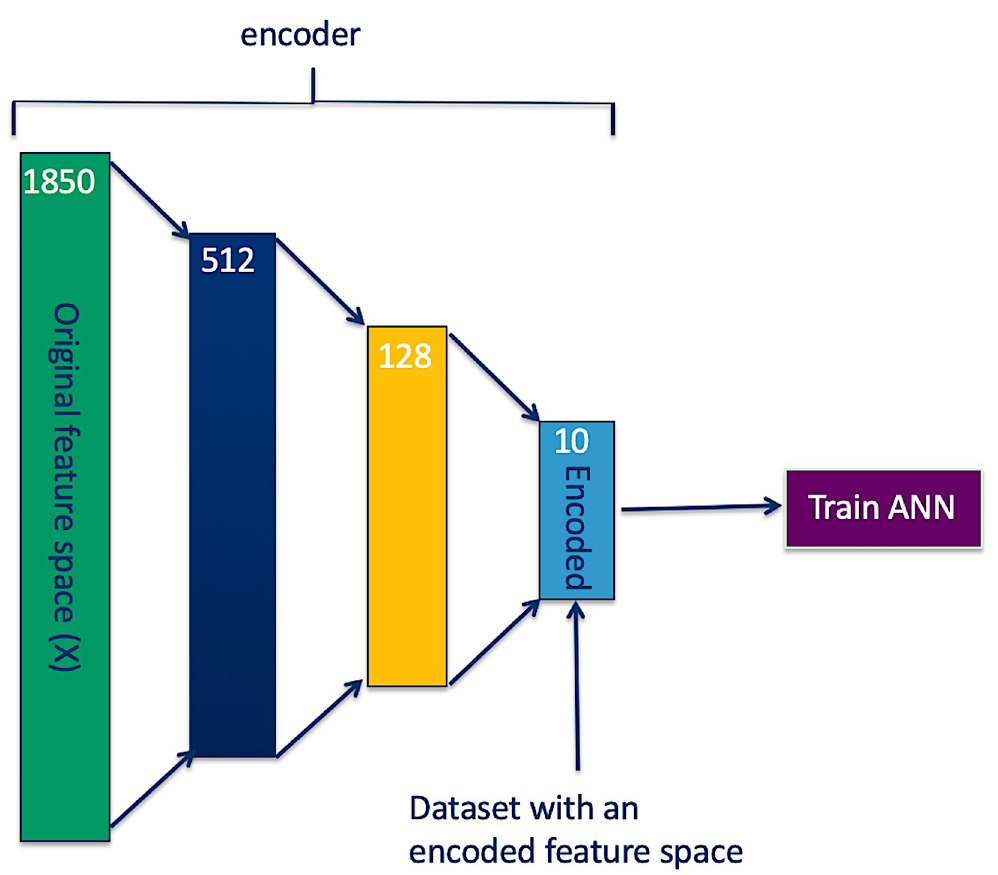
Fig 3. ANN model trained on a dataset with an encoded feature